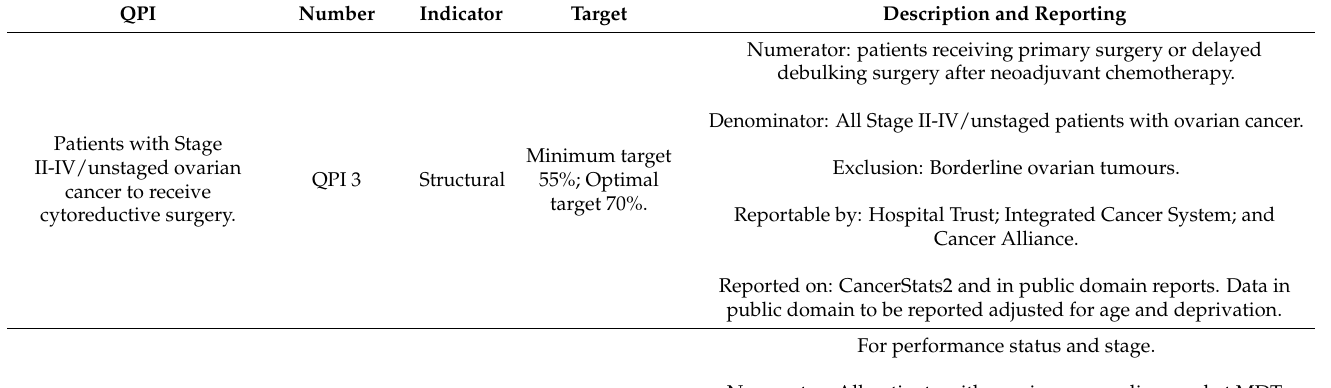
Description and